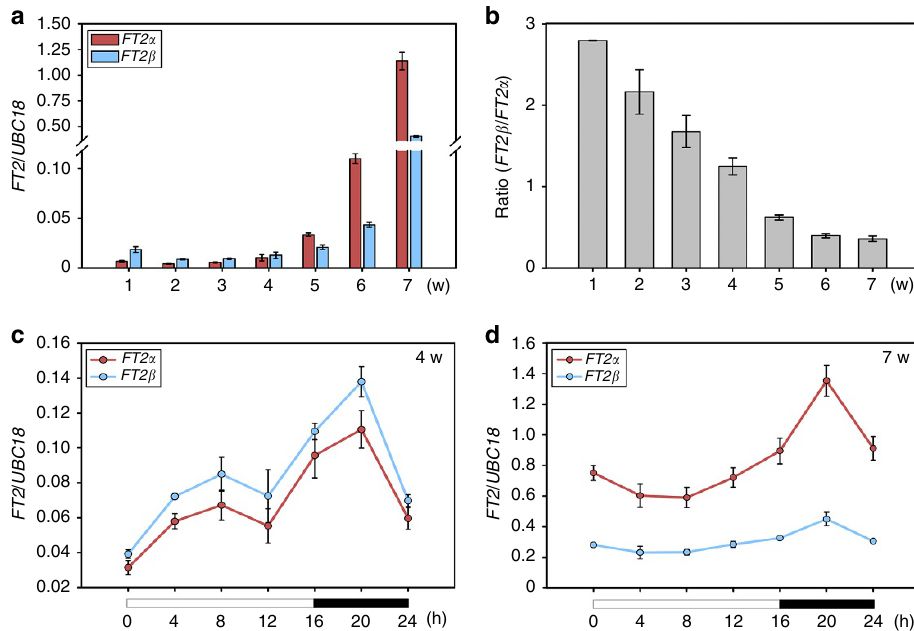
Figure 5 | Age-dependent FT2 AS. ( a ) Expression analysis of FT2 a and FT2 b along with different age. Upper flat leaves from five Bd21 plants with the indicated age were pooled and collected for RNA isolation. Each qRT-PCR analysis was performed in three biological replicates with similar results. The point represents the mean value of three technical replicates in a representative biological experiment. The transition from vegetative to reproductive stage of Bd21 plants occurs at 4–5 weeks. Standard curve for FT2 a , FT2 b and UBC18 quantification is shown in Supplementary Fig. 2. The absolute value of FT2 a , FT2 b and UBC18 is shown in Supplementary Fig. 10a. Error bars indicate s.d. w, weeks. ( b ) FT2 b /FT2 a ratio during plant development. ( c ) and ( d ) Diurnal expression analysis of FT2 a and FT2 b in 24-h period when plants were 4 and 7 weeks old. The absolute value of FT2 a , FT2 b and UBC18 at each time point is shown in Supplementary Fig. 12. Upper flat leaves from five Bd21 plants at the indicated time were pooled and collected for RNA isolation. The white and black bars along the horizontal axes represent light and dark periods, respectively. The numbers below the horizontal axes indicate the time in hours. Error bars indicate s.d. h, hours, w,